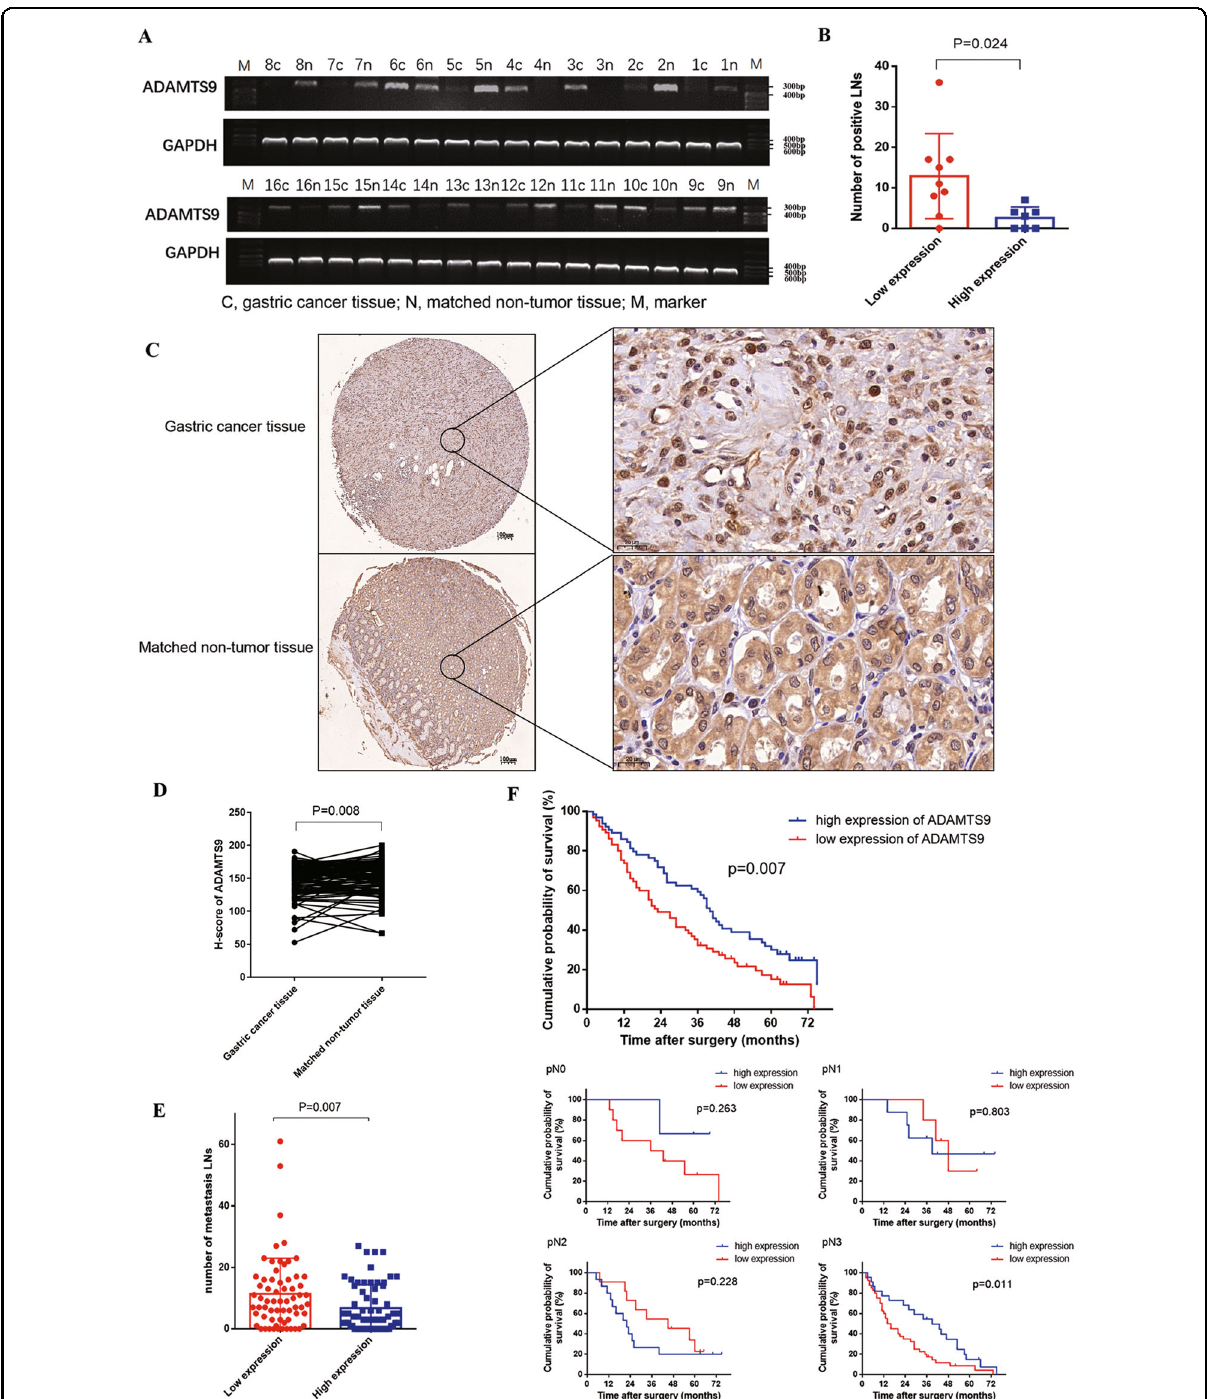
Fig. 1 Low expression of ADAMTS9 in GC tissues was associated with the more metastatic LNs and the poorer survival outcomes of GC patients. A mRNA expression levels of ADAMTS9 in GC tissues and matched non-tumor tissues were analyzed by reverse transcriptase PCR assay. B Correlation analysis was performed between ADAMTS9 mRNA expression and metastatic LNs. C Protein expression levels of ADAMTS9 in GC tissues and matched adjacent non-tumor tissues were analyzed by IHC assay. D ADAMTS9 protein was signi fi cantly decreased in GC tissues. E Low expression level of ADAMTS9 was closely associated with more metastatic LNs in GC patients. F Keplan – Meier survival analysis was performed in 129 GC patients and strati fi cation by pN